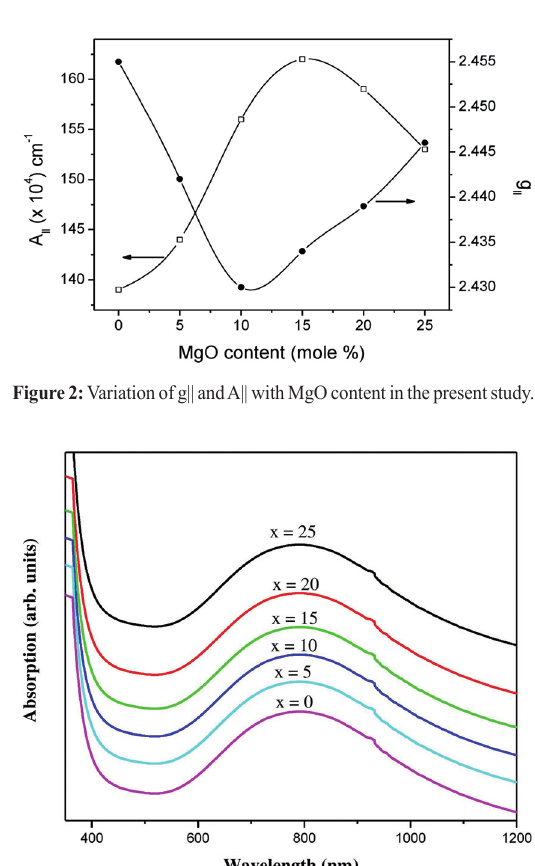
where K 2 is the orbital reduction factor (=